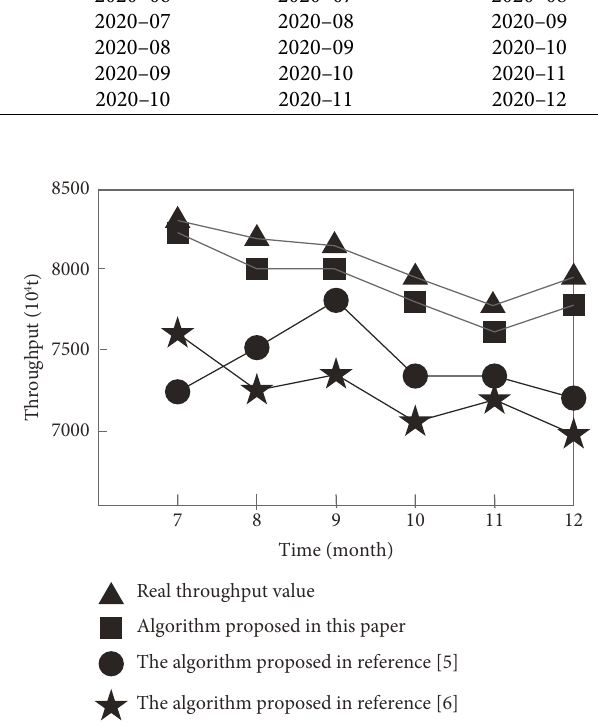
Figure 3: Predicted and actual values of different